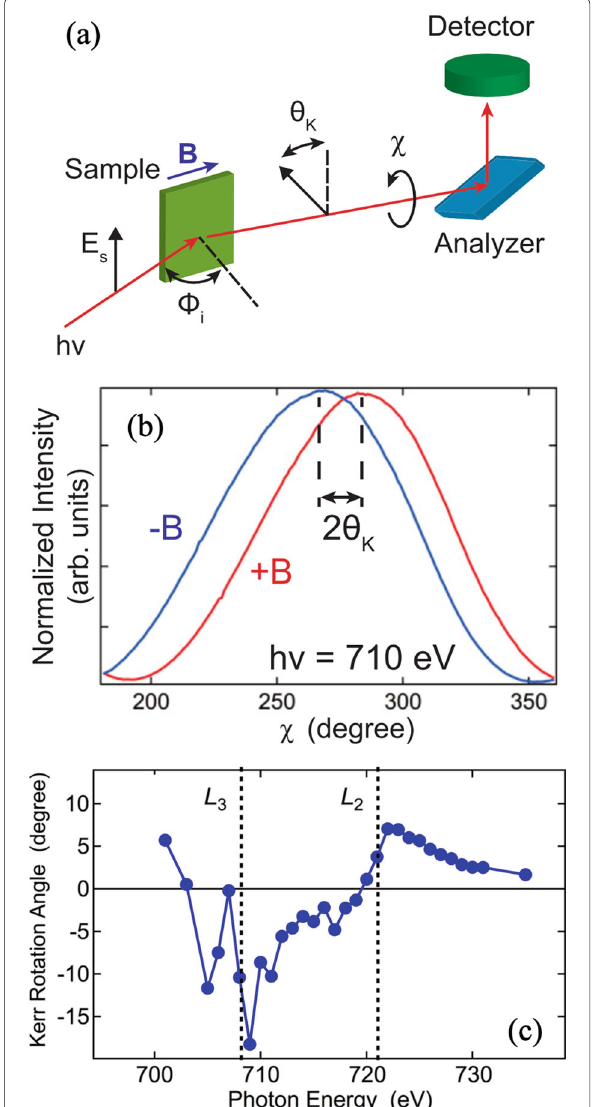
Fig. 23 Soft X-ray MOKE experiment [31]. a A measurement setup of the L-MOKE measurement with a unit of the rotating-analyzer ellipsometry (RAE), which consists of an analyzer (multilayer mirror) and a detector (multi-channel plate). b Intensity variation at the detector with rotation angle, χ , of the 30-nm-thick Fe film taken at h ν = 710 eV (Fe L -edge). The red and blue solid lines represent the data taken under the magnetic fields of magnetic flux density at +0.3 T (+B) and − 0.3T ( − B ) , respectively. The magneto-optical Kerr rotation angle, θ K , canbedetermined from 2 θ K = θ( − B ) − θ( + B ) . c A spectrum of θ K of the Fe nanofilm at Fe L 2,3